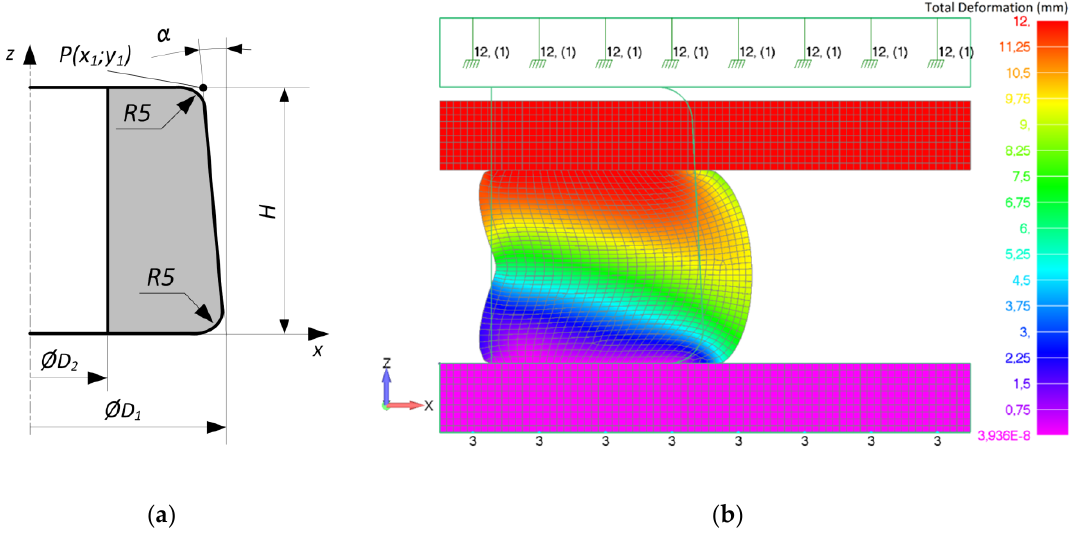
Figure 1. ( a ) The meridian section of the investigated rubber bumper and its geometry parameters. ( b ) Finite element model of the rubber bumper and the deformation state obtained at 12 mm displacement load.